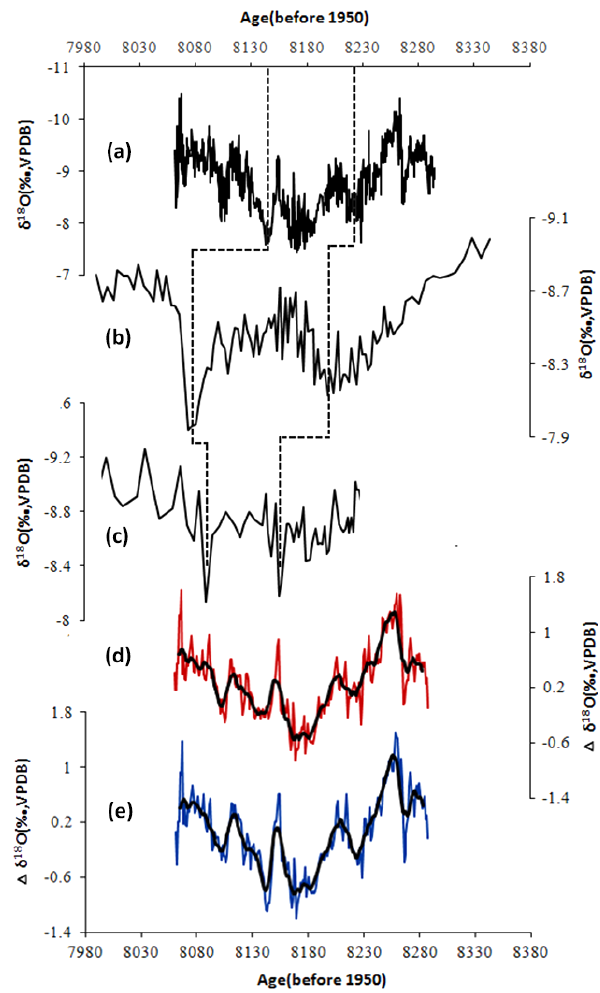
Figure 2. Original δ 18 O stalagmite records adopted in this paper displayed with (cid:49)δ 18 O sequences between stalagmites from Dongge and Heshang. (a) HS4 δ 18 O record from Heshang cave (Liu et al., 2013); (b) DA δ 18 O record from Dongge cave (Cheng et al., 2009); (c) D4 δ 18 O record from Dongge cave (Cheng et al., 2009); (d) (cid:49)δ 18 O between DA and HS4 (red) with a 10-year moving aver- age (black); (e) (cid:49)δ 18 O between D4 and HS4 (blue) with a 10-year moving average (black). The dashed lines show matched peaks from each original record.